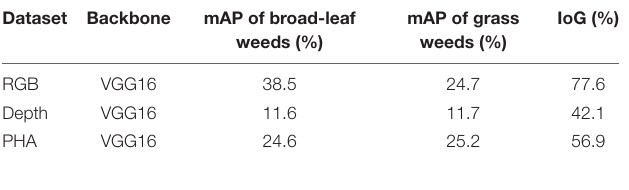
TABLE 2 | Weeds detection with single-modal datasets. Dataset Backbone